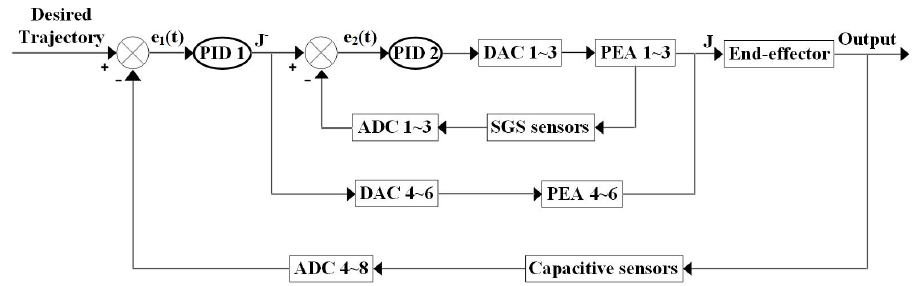
Figure 19. Controller architecture for in-plane trajectory tracking.